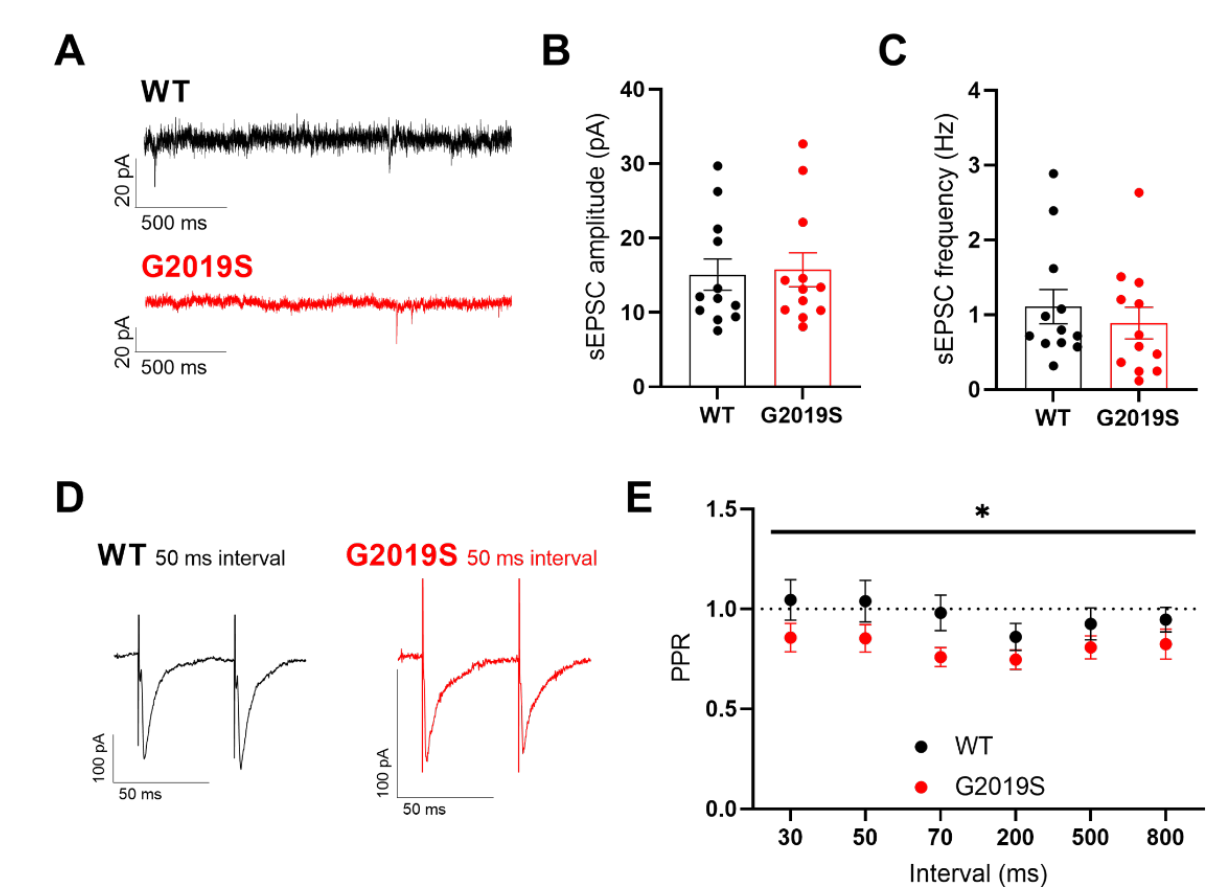
Figure 2. Glutamatergic synaptic transmission in SNr neurons. ( A ) Example traces of whole-cell voltage-clamp recordings of sEPSCs obtained in two SNr neurons from a WT mouse and a G2019S mouse. ( B ) The amplitude of sEPSCs recorded from SNr neurons was not different between WT and G2019S mice (WT: 15.09 ± 2.1 pA, n = 12 cells from N = 6 mice; G2019S: 15.74 ± 2.3 pA, n = 12 cells from N = 5 mice; Mann-Whitney test, p = 0.71). ( C ) The frequency of sEPSCs recorded from SNr neurons was not different between WT and G2019S mice (WT: 1.11 ± 0.23 Hz, n = 12 cells from N = 6 mice; G2019S: 0.89 ± 0.21 Hz, n = 12 cells from N = 5 mice; Mann-Whitney test, p = 0.4). ( D , E ) The paired-pulse ratio (PPR) of paired EPSCs evoked in SNr neurons at different stimulus intervals showed a significant increase in paired-pulse depression in G2019S mice when compared to WT mice (WT: n = 11 cells from N = 8 mice; G2019S: n = 10 cells from N = 9 mice; repeated